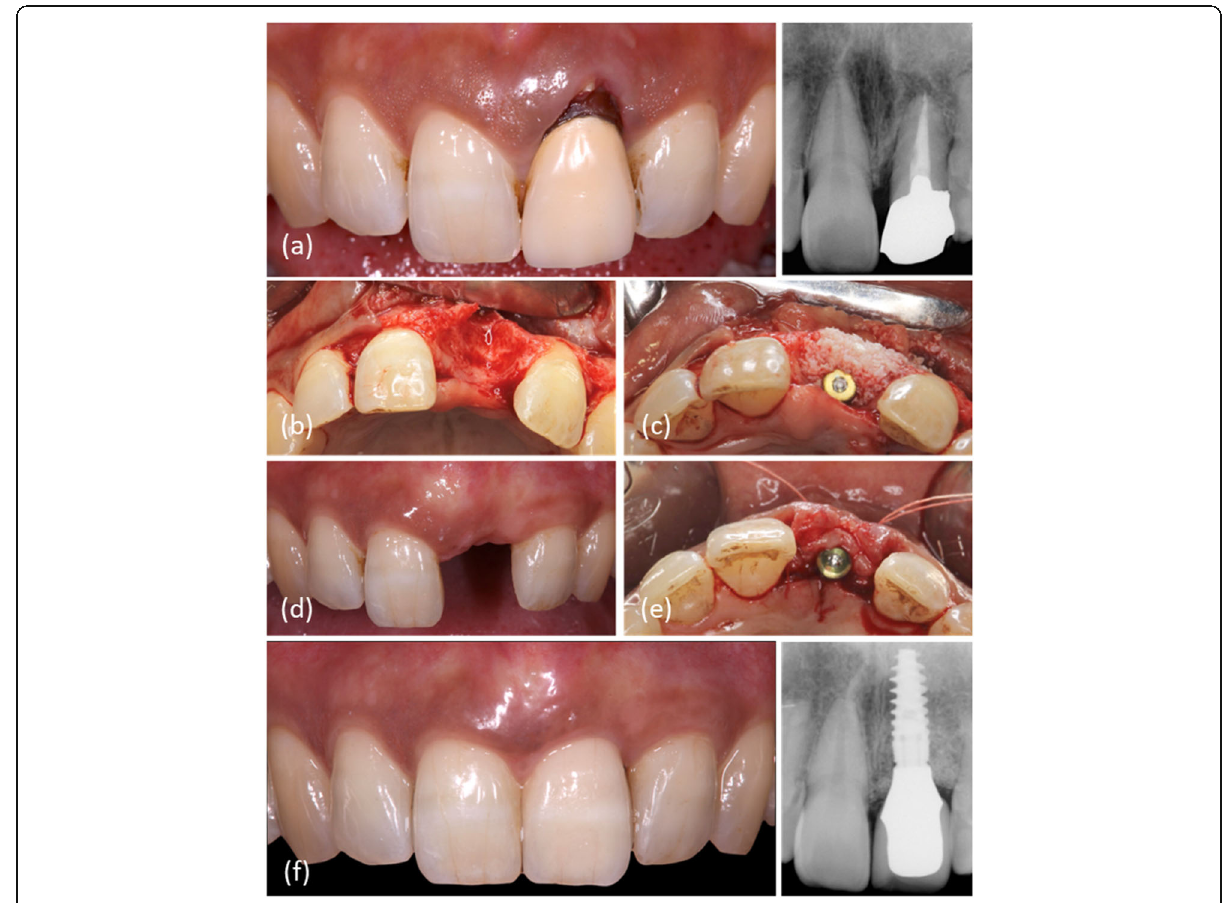
Fig. 1 The surgical and prosthesis procedures of the test group. a Buccal view of the preoperative situation. b A mucoperiosteal flap was raised, and the tooth was extracted. c Deproteinized bovine bone was inserted into the implant-socket gap. d Buccal view before the second surgery. e Connective tissue was placed in a supraperiosteal envelope flap. f Buccal view after definitive prosthesis